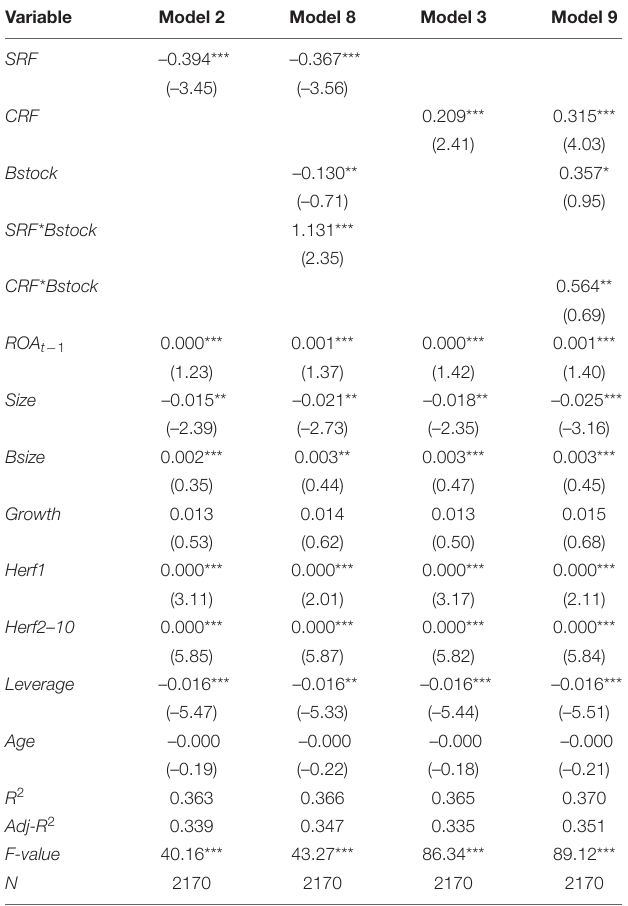
TABLE 5 | Impact of board ownership on the relationship between board faultlines and innovation strategy decisions.